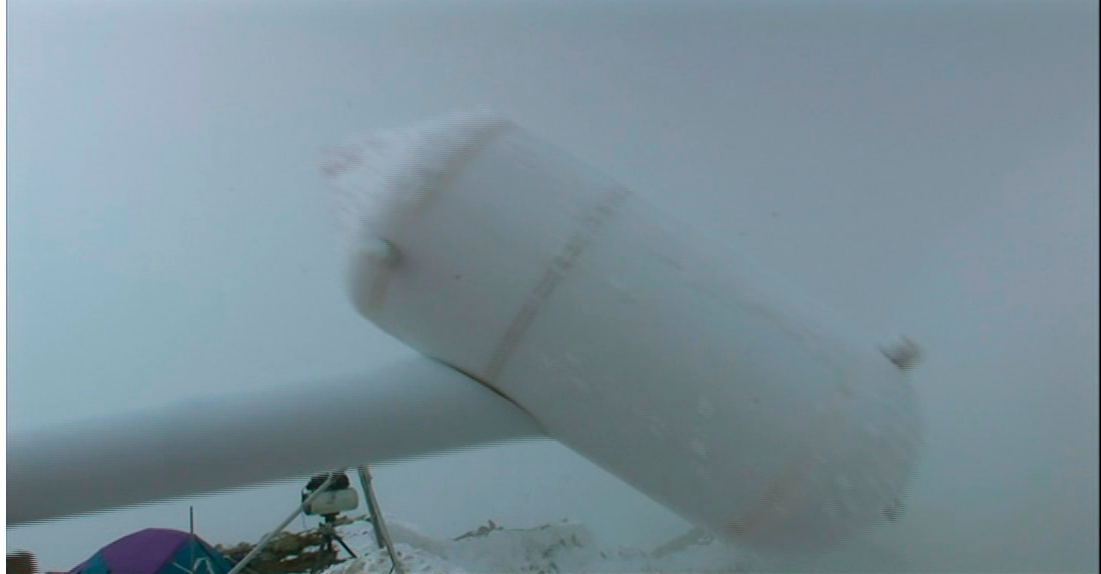
Figure 5. A camera pointed into the crater of Mount Erebus.